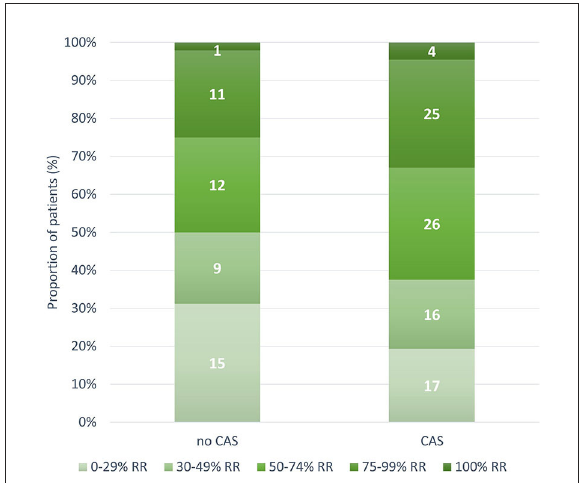
FIGURE3 Number and proportion of patients with 0 to 29, 30 to 49, 50 to 74, 75 to 99, and 100% response rate according to the presence of cranial autonomic symptoms ( P = 0.561). CAS, Cranial Autonomic Symptoms; RR, response rate.